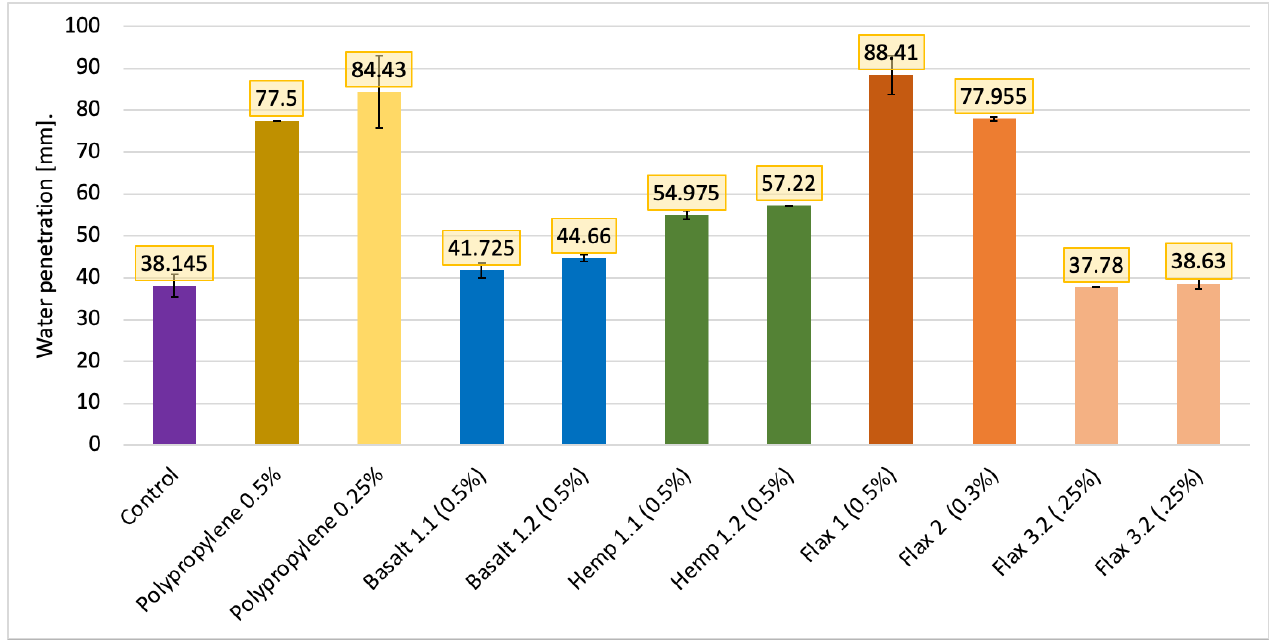
Figure 18. Water penetration